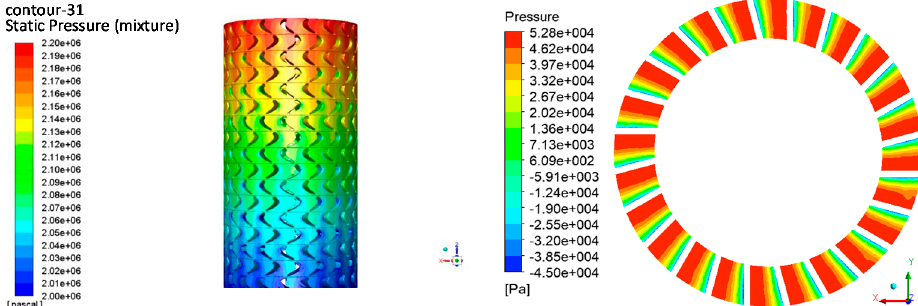
Figure 8. Pressure contour diagram of full − cycle multi − stage turbodrill blades.